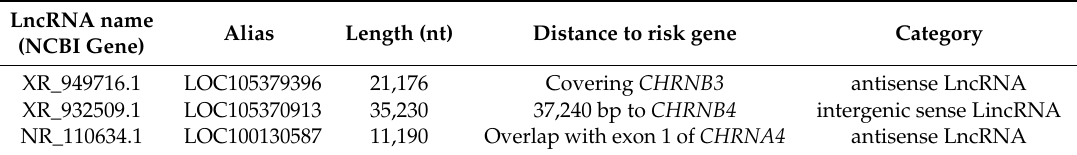
Table 6. The long non-coding RNAs (LncRNAs) proximate to the three replicable CHRN genes.